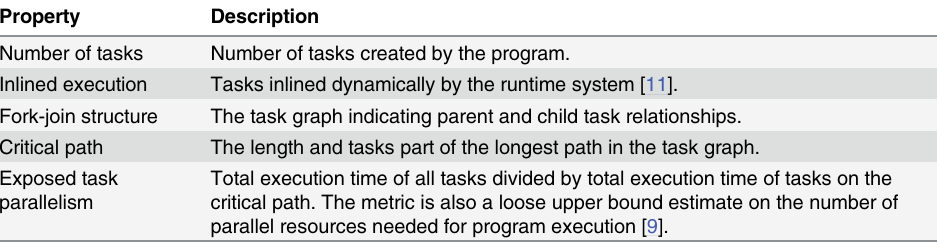
Table 1. Task graph